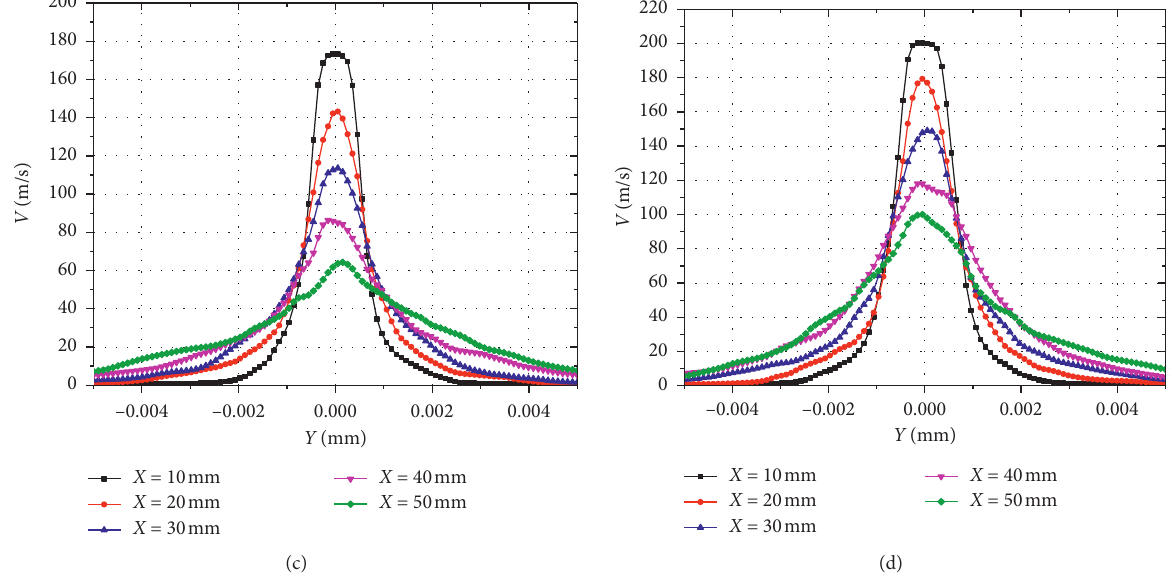
Figure 16: Velocity distributions along the radial direction under different cavitation numbers. (a) σ � 0.0203. (b) σ � 0.0101. (c) σ � 0.0068. (d) σ � 0.0051.